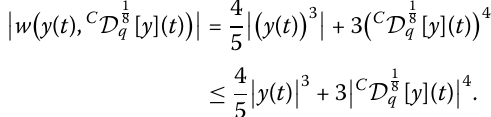
, 1 , 7 in Example 4.1 5 2 8